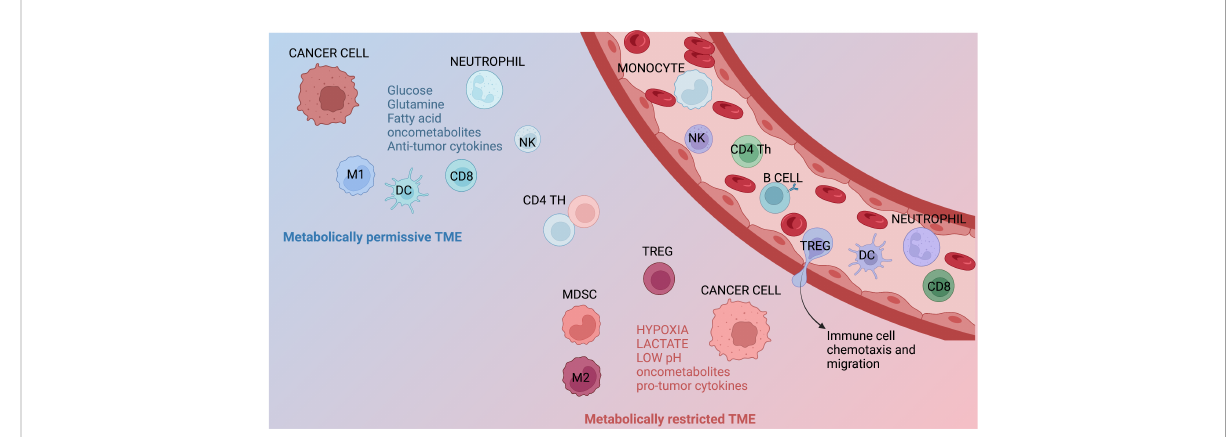
FIGURE 2 Metabolic features of the TME. Immune in fi ltrates contribute to generate metabolically permissive or restricted tumor microenvironment (TME). Immune populations that generally lead to a metabolically permissive TME are neutrophils, M1 macrophages, dendritic cells (DCs), NK cells, and CD8 + T cells. Immune subsets generating metabolically restricted TME are represented by M2 macrophages, regulatory T (Treg) cells, and myeloid-derived suppressor cells (MDSCs). Several other factors, including hypoxia, restricted/augmented nutrient availability, low pH, the presence of metabolites/oncometabolites, and/or speci fi c cytokines or chemokines, can also contribute affect the metabolic characteristics of the